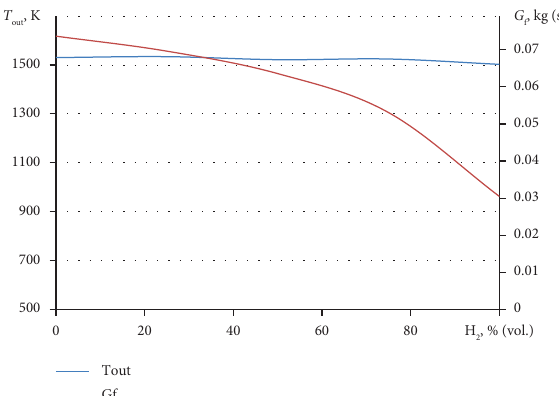
Figure 6: Dependences of gas temperature at the combustion chamber’s outlet and fuel mass fow rate on the volume content of hydrogen in the mixture.